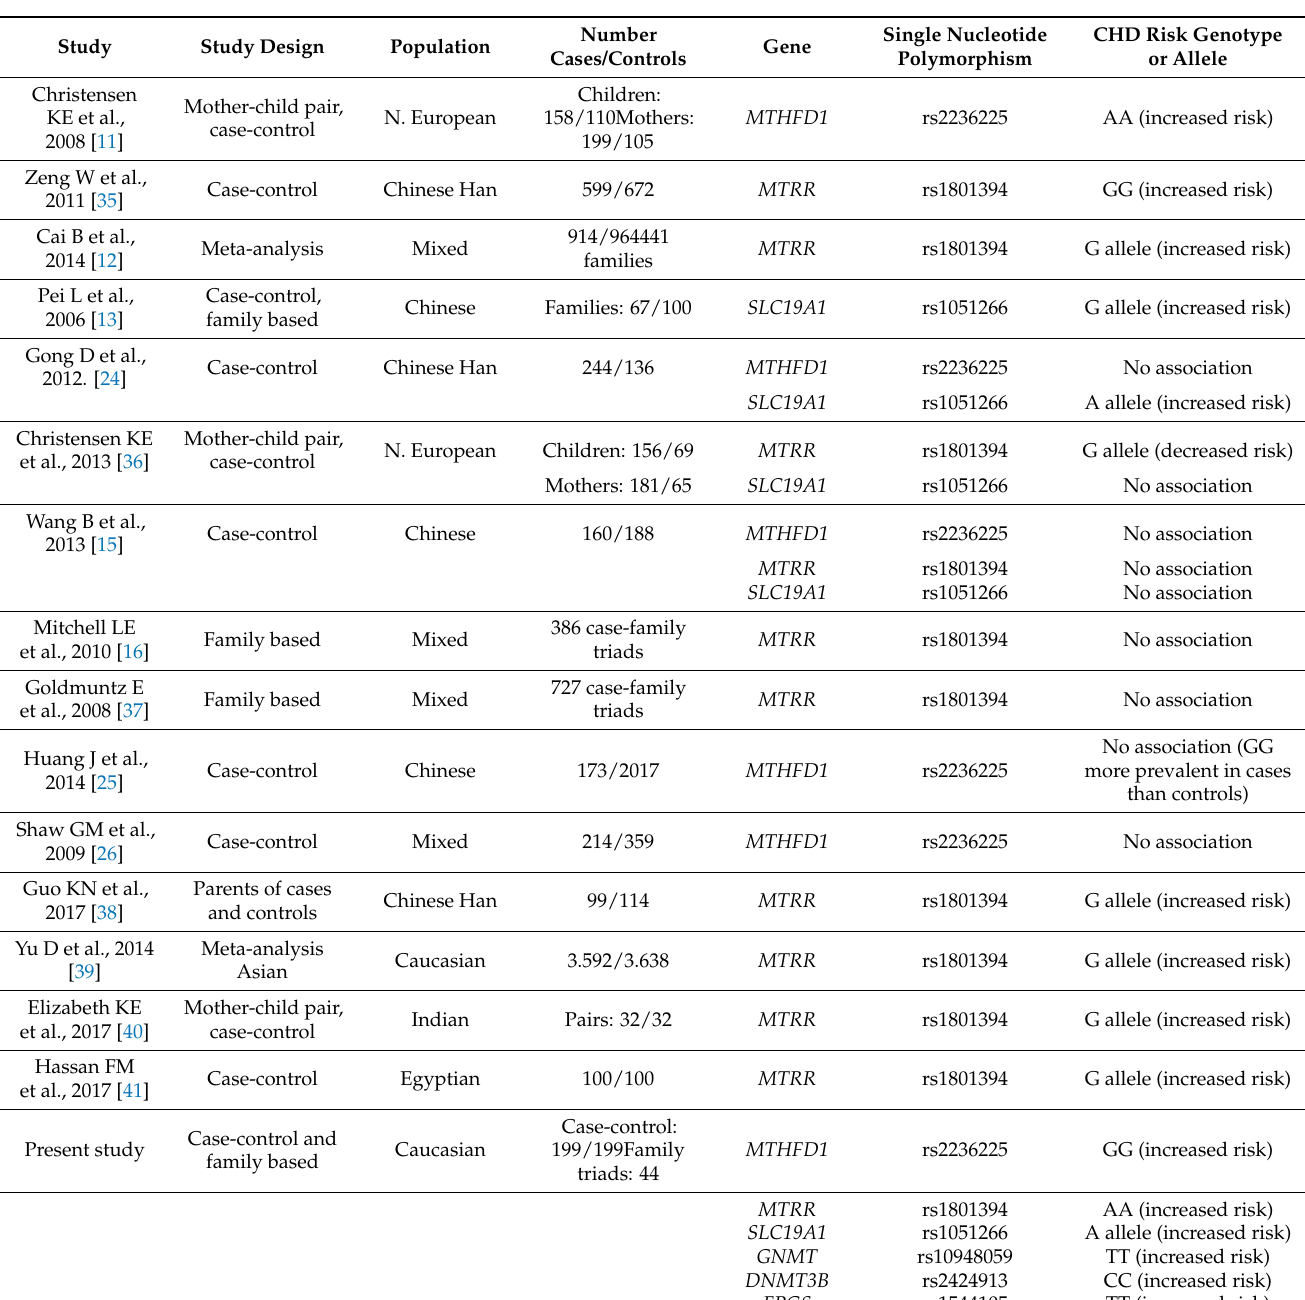
solute carrier family 19 member 1; CHDs, congenital heart